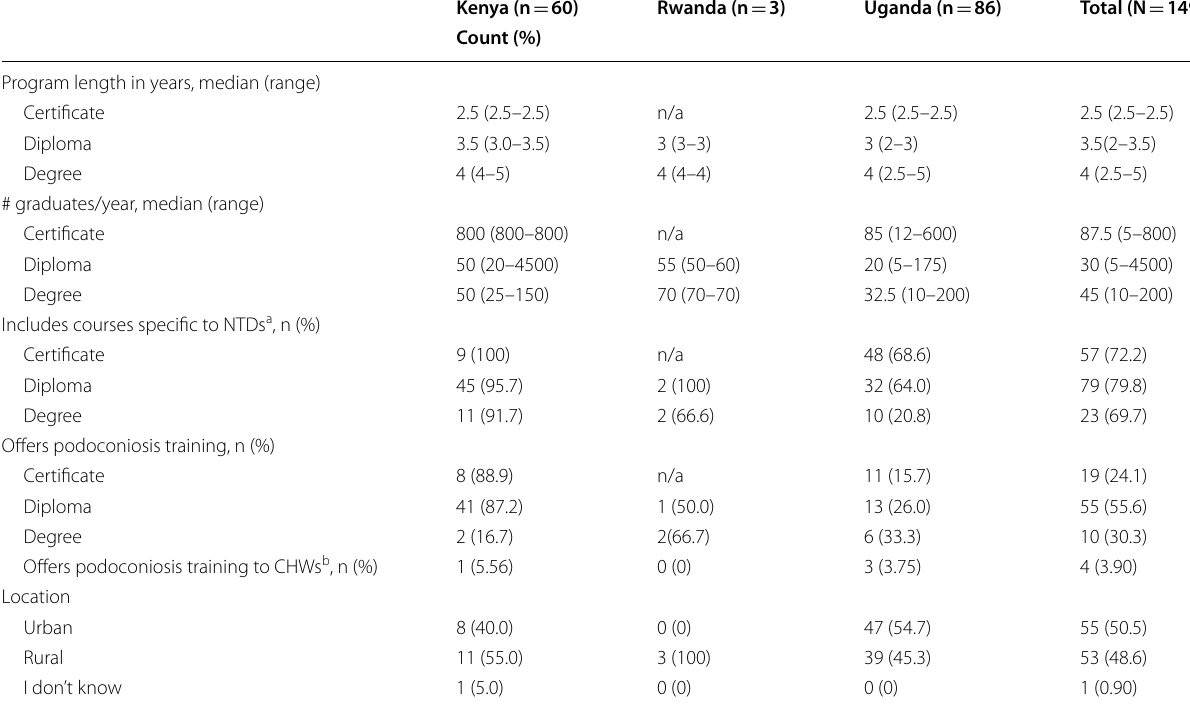
Table 3 Program characteristics of government-accredited post-secondary institutions offering nursing programs in podoconiosis- endemic countries in East Africa (N =